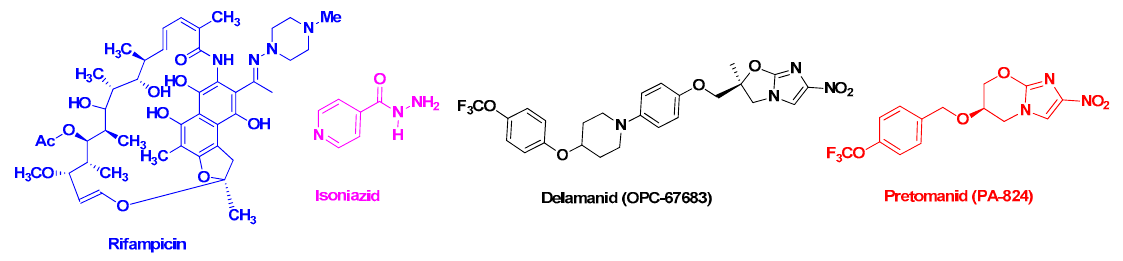
Figure 2. Chemical structures of Rifampicin (RIF), Isoniazid (INH), Delamanid, and Pretonamid.